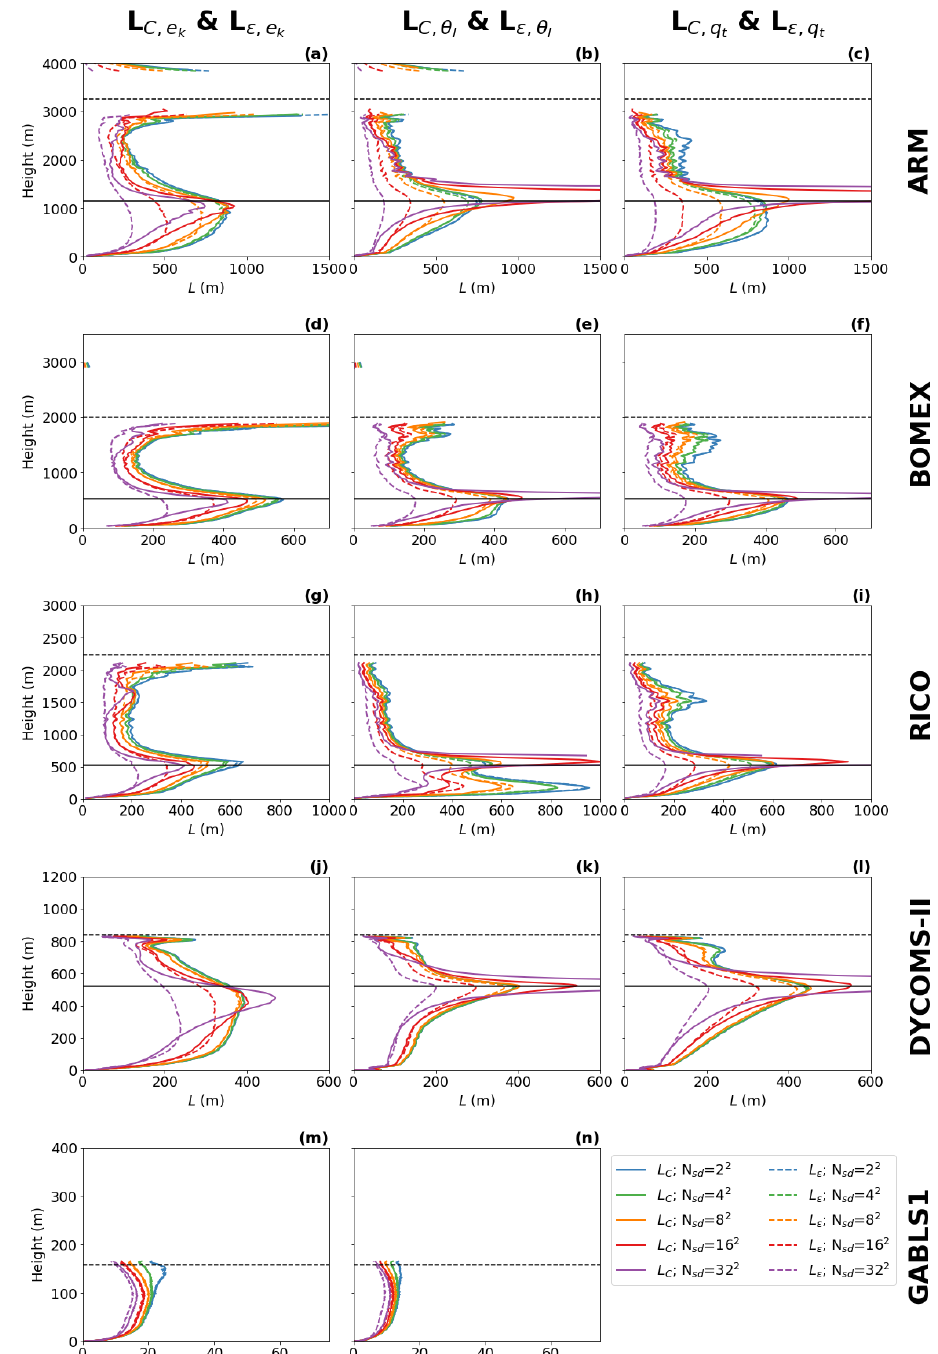
Figure 2. The scale dependence of the turbulence length scale diagnostics based on the TKE budget (1st column; a , d , g , j , m ), the θ l variance budget (2nd column; b , e , h , k , n ), and the q t variance budget (3rd column; c , f , i , l ) for the five boundary layer cases (rows). The different sub-domain sizes are represented by different colors of lines, where the full lines are our new diagnostics ( L C ) and dashed lines are the classical diagnostics ( L (cid:101) ). N sd indicates the number of sub-domains. L C , q are not plotted for the dry GABLS1 case. The budgets are plotted for the ARM case after 10 h of integration, for the BOMEX and the RICO case after 7 h of integration and for the DYCOMS-II case and the GABLS1 case after 3 h of integration. The horizontal black dashed lines indicate the ABL height, and the horizontal black solid lines indicate the cloud base